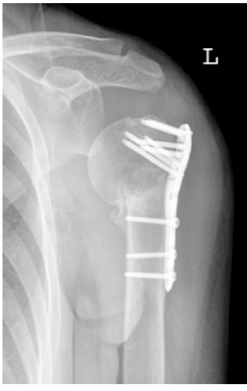
Figure 5. Complication Type 1. a.p. radiograph of the left shoulder after angular stable plate osteosynthesis illustrates mild varus displacement of the humeral head. The humeral head cortex remains intact, so there is no screw cutout.